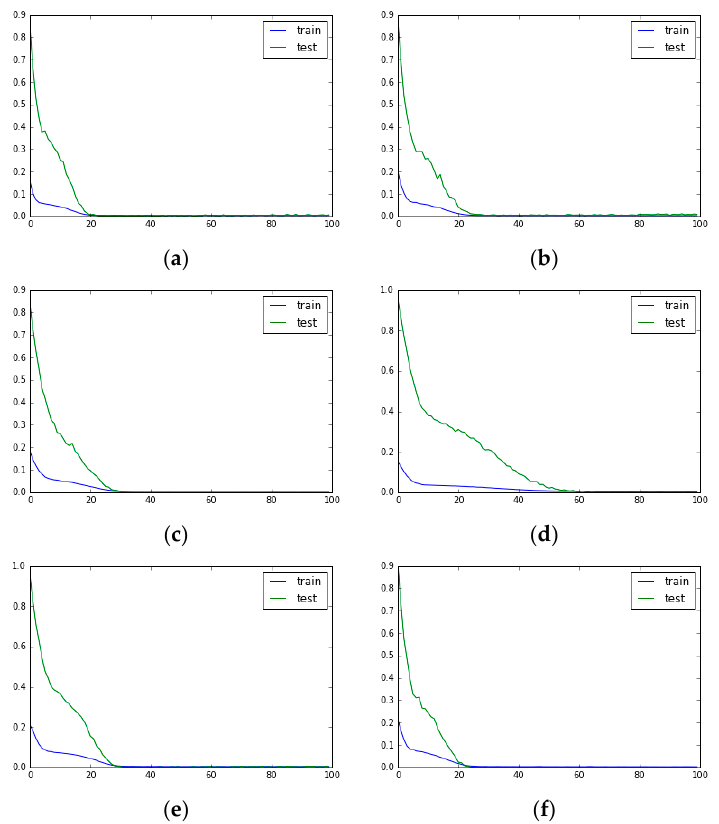
Figure 16. Loss of 6 escalators using DCLNN for training and prediction. ( a ) Escalator #1. ( b ) Escalator